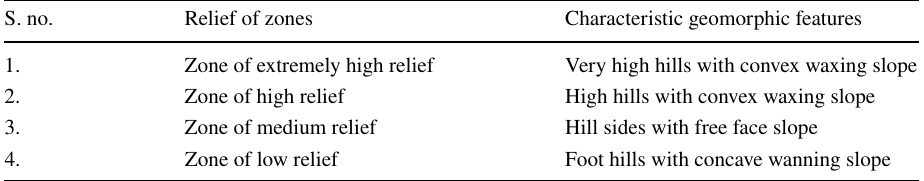
Table 4 Relief zones: Gangotri glacier valley, Garhwal